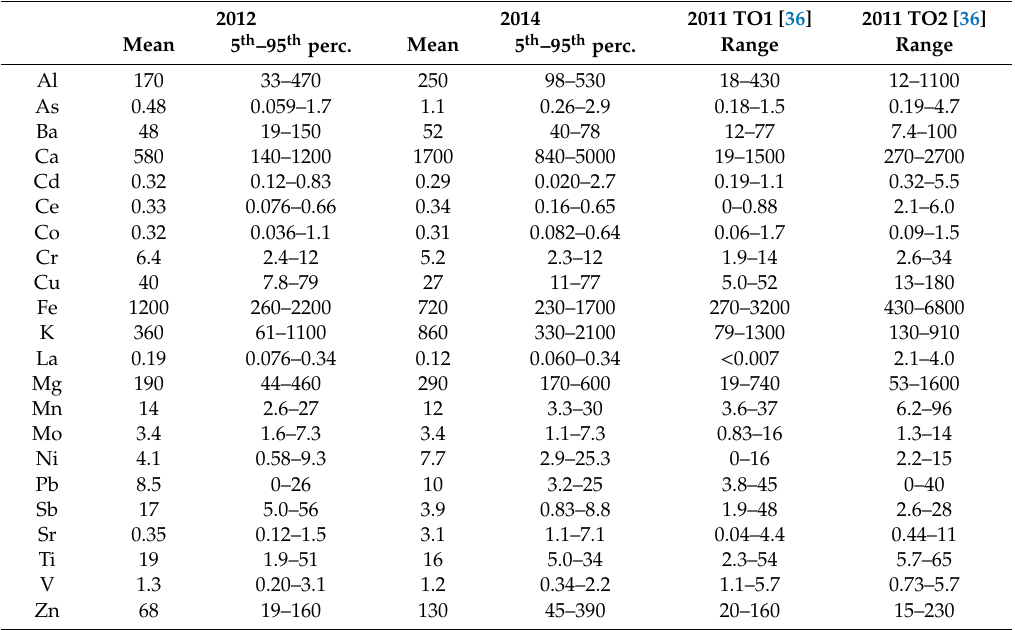
Figure 5. Pollution roses for 2014 samples, showing a combination of the analyte concentration (ng / m 3 ) and the prevailing wind direction. Table 1. Descriptive statistics of the inorganic composition of the PM 10 collected in 2012 and 2014. For comparison, the concentration ranges found by Padoan et al. [36] in other two sampling sites are also reported. All the concentrations are expressed in ng / m 3